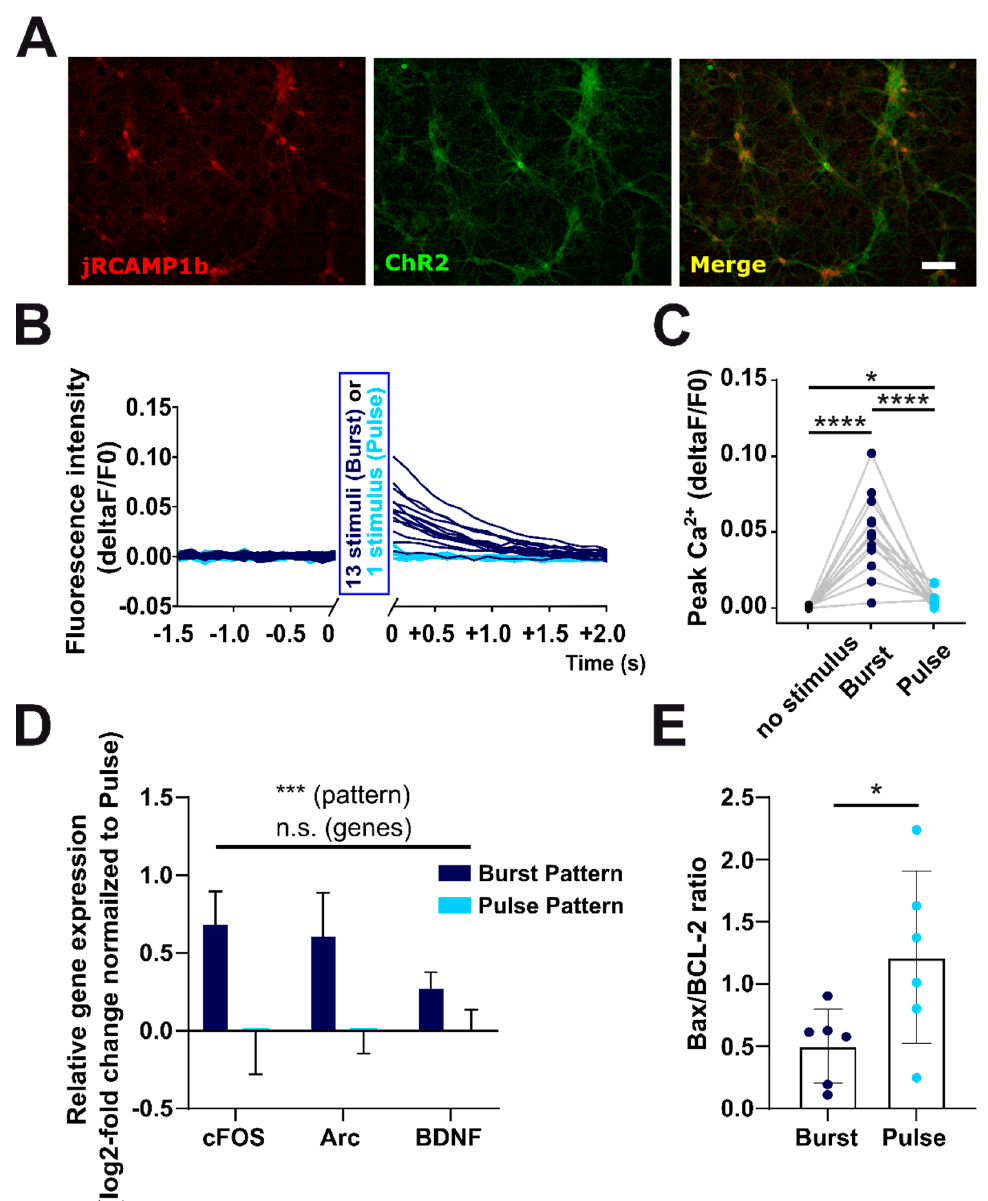
Figure 7. Activity-pattern-dependent regulation of neuronal Ca 2+ and gene expression precedes differences in neuronal cell death. ( A ) Representative images show the jRCAMP1b and ChR2-signal as well as the merged signal in cortical neurons at DIV 14. ( B ) Average Ca 2+ response of ChR2-positive neurons after a single pulse-like stimulus (light blue) and after a burst-like stimulation (dark blue, traces aligned to the last stimulus in the burst). The control intervals before the stimuli were aligned to the onset of the stimulus or the onset of the first stimulus in the burst, respectively. Ca 2+ signals were acquired by imaging with the red Ca 2+ indicator jRCAMP1b. ( C ) Peak intensity of optogenetically induced calcium response was significantly smaller upon pulse stimulation as compared to burst stimulation ( n = 14 cells; p < 0.01). ( D ) Comparison of gene expression between cultures subjected to burst or pulse stimulus pattern for 48 h showed significant differences in regulation of classical activity regulated targets (BDNF, cFOS and arc) ( n = 6/cultures; p < 0.001). ( E ) In line with a lower survival rate after 72 h, cortical neurons exposed to non-physiological pulse stimulus pattern present a significantly higher Bax/Bcl2 ratio already after 48 h of optogenetic stimulation ( n = 6/6 cultures; p < 0.05). Scale bar represents 50 µm. Data points indicate mean ± SEM and *, ***and **** indicate p -values <0.05, 0.001, and 0.0001, respectively.